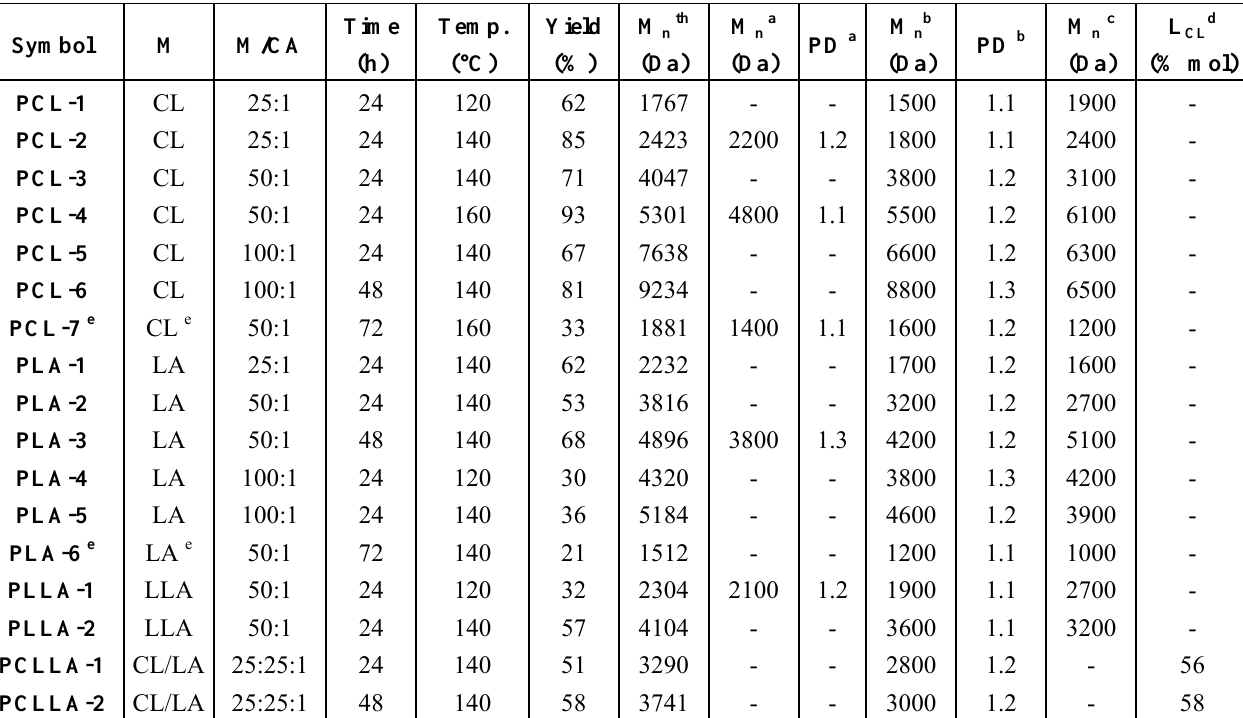
Table 1. Homo- and copolymerization of cyclic